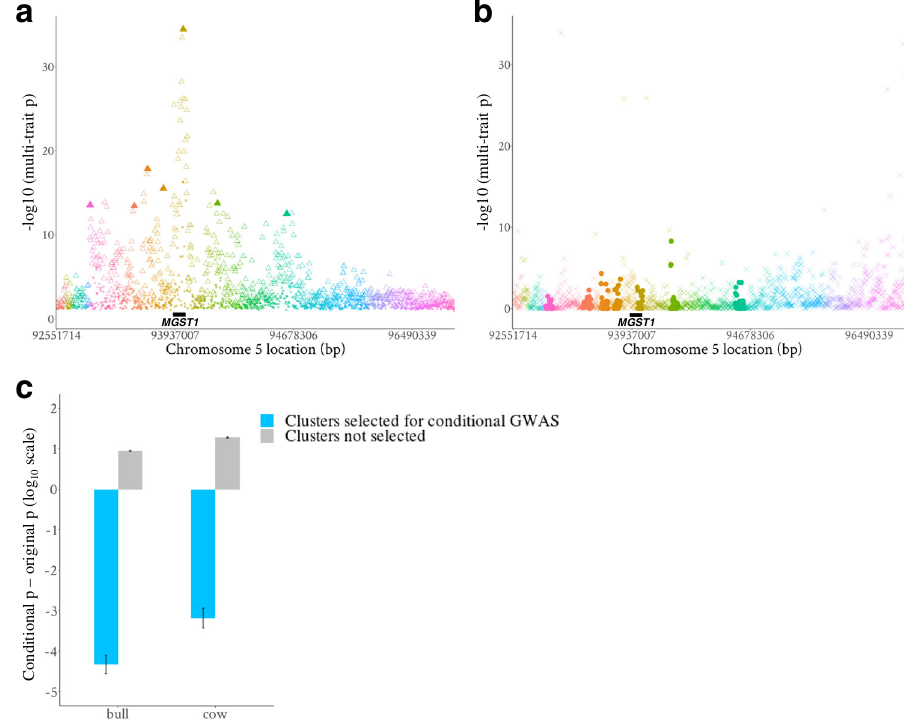
Fig. 2 Examples of variant clustering and prioritization and results of the conditional analysis. a Manhattan plot of the sliding-window containing the MGST1 gene. The y -axis is the multi-trait p -value of 34 bull traits in this region. Different symbol colours indicate variants in different clusters. Empty triangles are those variants within the top 50% ranking of multi-trait p -value adjusted (divided) by FAETH score. These variants across all sliding-windows made up the 165k prioritized variants in both sexes. The solid triangles are among the top 100 variants that appeared in both bull and cow set of prioritized 165k variants and these 100 variants were fi tted as covariates in the GWAS for conditional analysis. b Manhattan plot of the conditional analysis of the window containing the MGST1 gene. The y -axis is the multi-trait p -value of the conditional GWAS of 34 bull traits when fi tting the top 100 variants in the model (i.e., the solid triangles in panel a ). Different symbol colours indicate membership of variants to clusters. Solid circles are the variants from those clusters in which the top 100 variants (e.g., solid triangles in a ) were selected, while crosses represent variants from those clusters that did not include a top 100 variant. c A bar plot showing the genome-wide difference of p -values between the conditional GWAS and of the original GWAS after combining sexes. The standard error bars of the mean are across more than 30,000 clusters selected and not selected for conditional